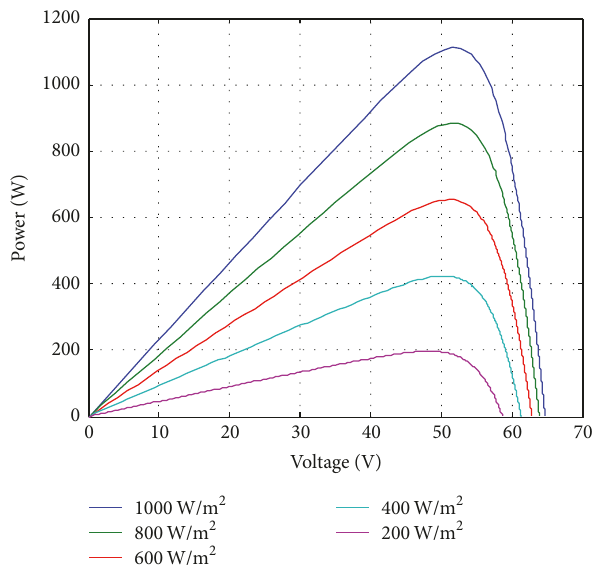
Figure 5: 𝑃 - 𝑉 curves for PV array.